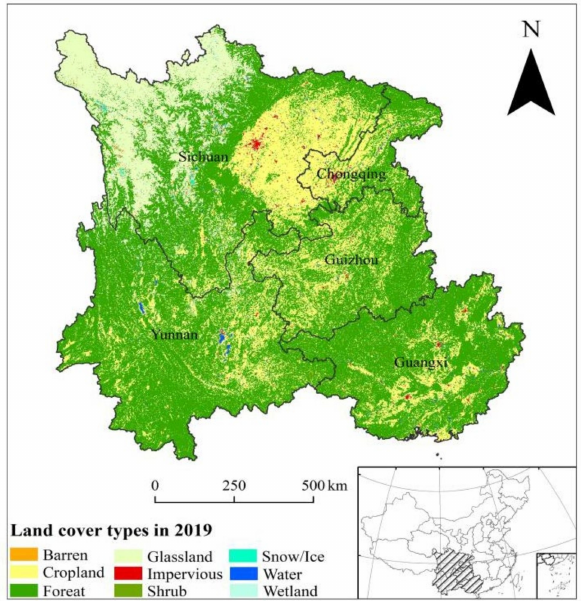
Figure 1. Study area location in China and land cover types in